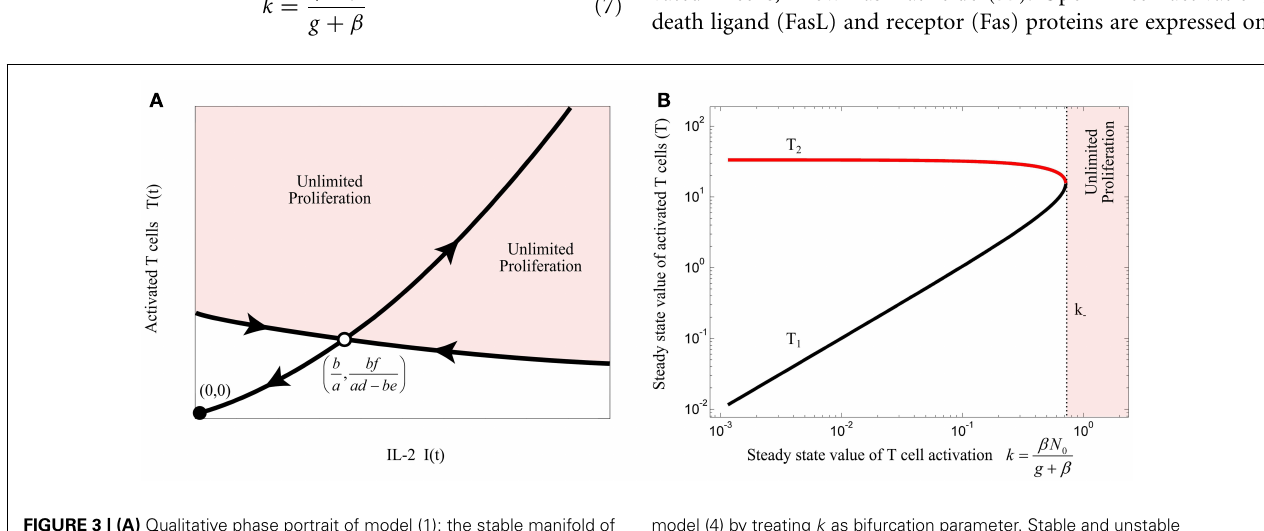
FIGURE 3 | (A) Qualitative phase portrait of model (1): the stable manifold of saddle node defines a threshold for the initial conditions that allow for unlimited proliferation of activated T cells. (B) Bifurcation diagram of